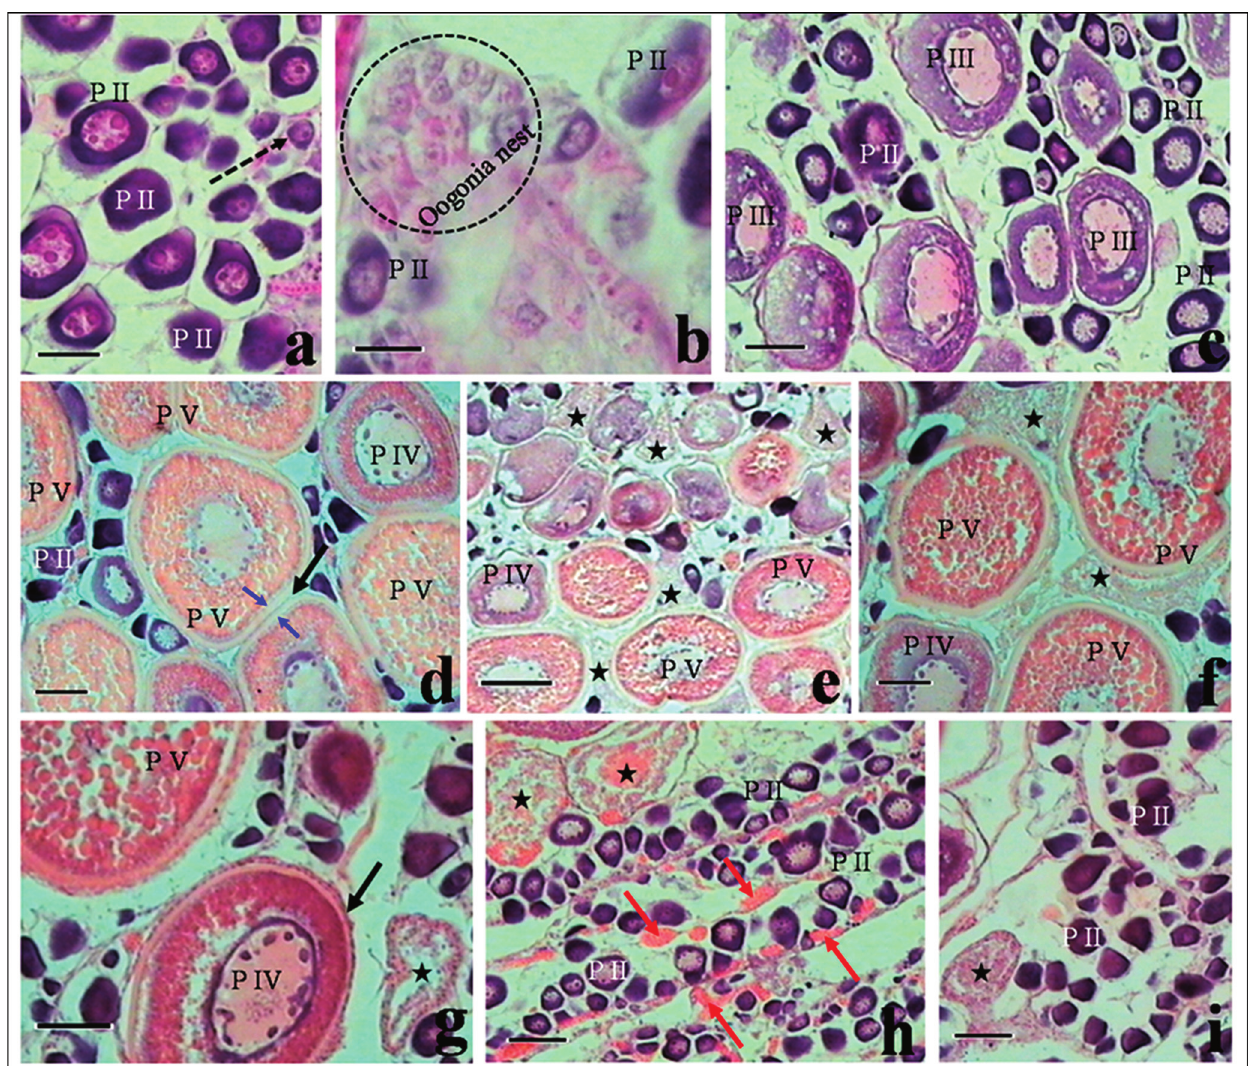
Fig. 3. Histology cuts of Etropus crossotus ovaries, stained with HE. a - Immature ovary containing ovarian follicles in phases I (arrow) and II (P II) (scale: 40 μ m); b - Immature ovary, in detail, containing an “oogonia nest” (circle) + follicles in phase II (scale: 20 μ m); c - Maturing ovary containing follicles in phases II and III (P III) (scale: 80 μ m); d - Mature ovary containing follicles in phases II, IV (P IV) and, predominantly, V (P V). The blue arrows point to the vitelline membrane and the black arrow indicates the zone of contact between the follicular cells of two follicles in phase V, separated by scarce connective tissue (scale: 80 μ m); e - Partially spawned ovary (panoramic view) containing follicles in phases II, IV and V + empty follicles (asterisk) (scale: 190 μ m); f - Partially spawned ovary containing ovarian follicles in phases IV and V + empty follicles (asterisk) (scale: 80 μ m); g - Partially spawned ovary (in detail) containing follicles in phases IV and V + empty follicles (asterisk). The arrow points to follicular cells (scale: 80 μ m); h - Spawned ovary containing cells in phase II + empty follicles (asterisk) + high degree of vascularization (scale: 80 μ m); i - Spawned ovary (in detail) containing follicles in phase II + empty follicles (asterisk) (scale: 80 μ